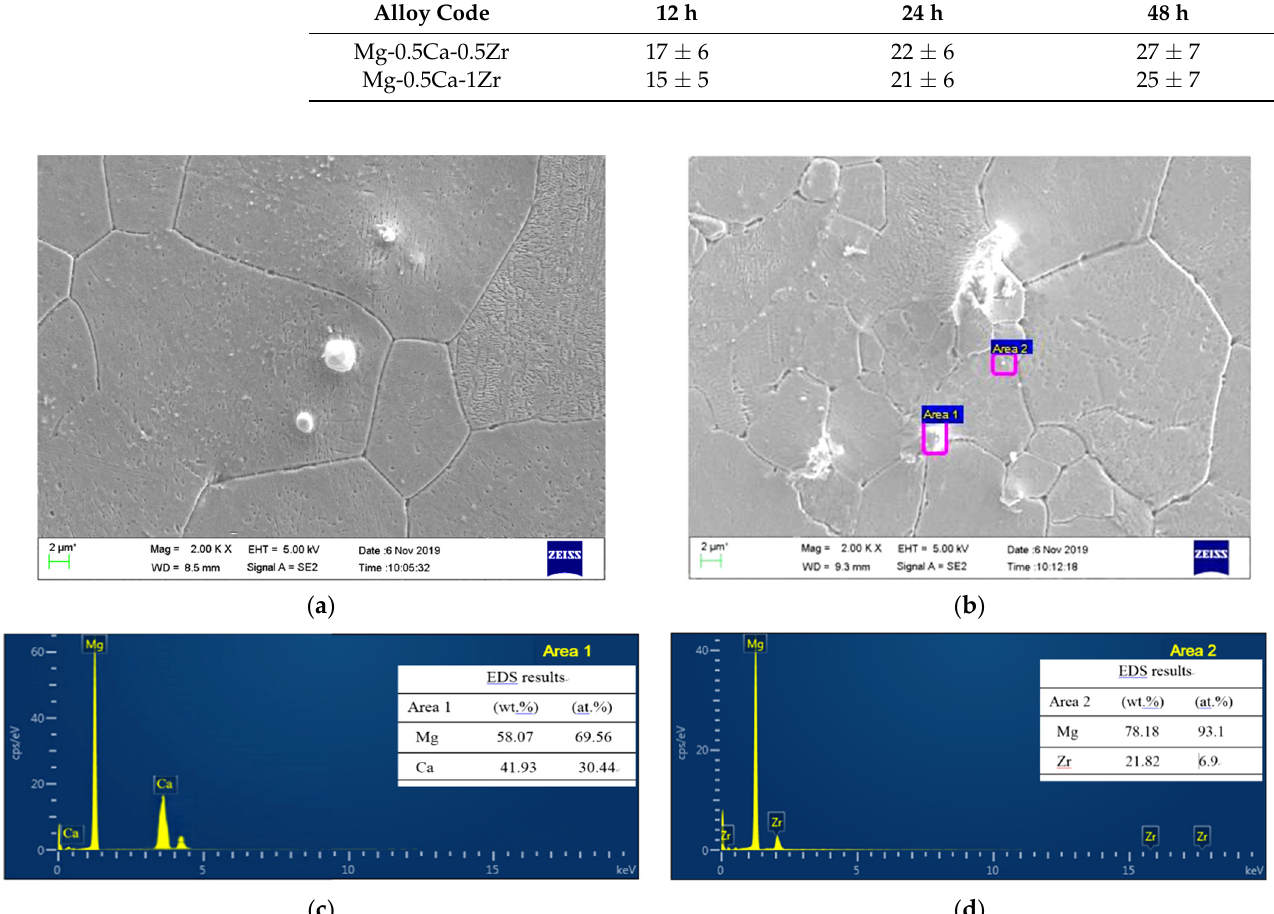
Figure 9. SEM microstructure of ( a ) Mg-0.5Ca-0.5Zr alloy aged for 12 h and ( b ) Mg-0.5Ca-1Zr alloy Table 1. Mean grain sizes of the aged Mg alloys with the aging time ( μ m).